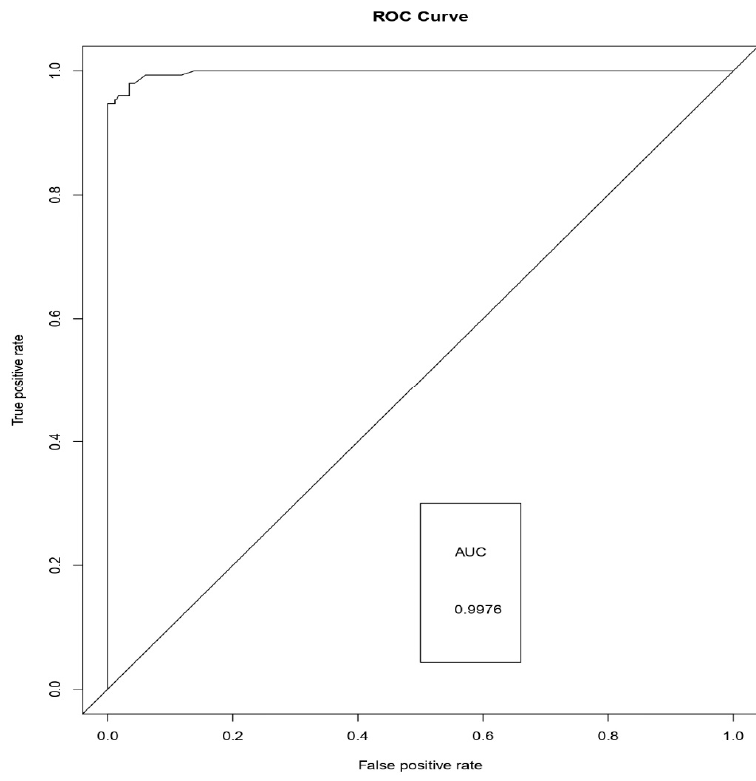
Figure 8. AUC-ROC curve for Weighted Average Ensemble Model.